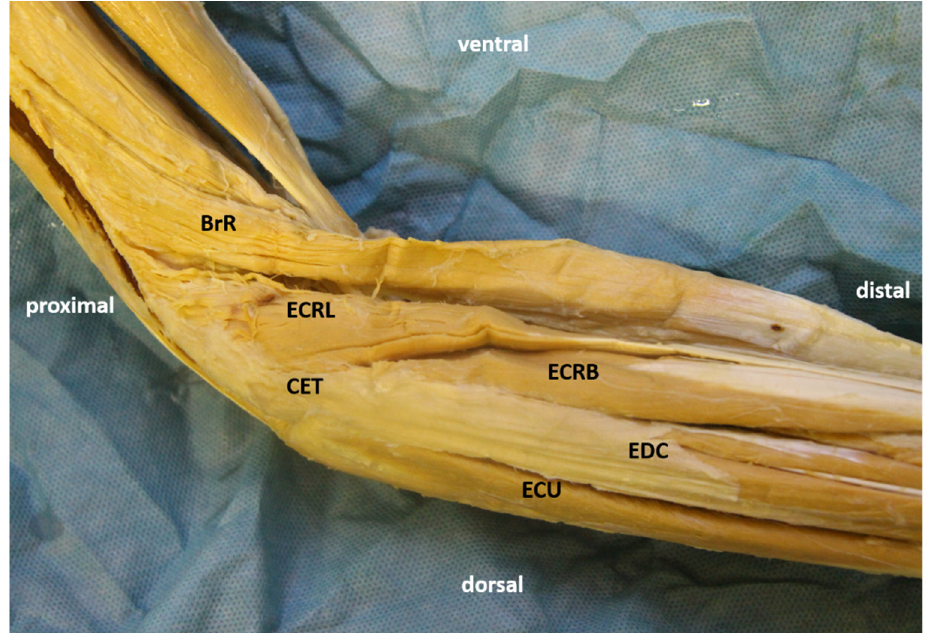
Figure 1. Common extensor origin. The cadaveric specimen shows the location of muscular origin on the posterolateral aspect of the right elbow joint. BrR: brachioradialis muscle, CET: common extensor tendon, ECRB: extensor carpi radialis brevis muscle, ECRL: extensor carpi radialis longus muscle, ECU: extensor carpi ulnaris muscle, EDC: extensor digitorum communis muscle.